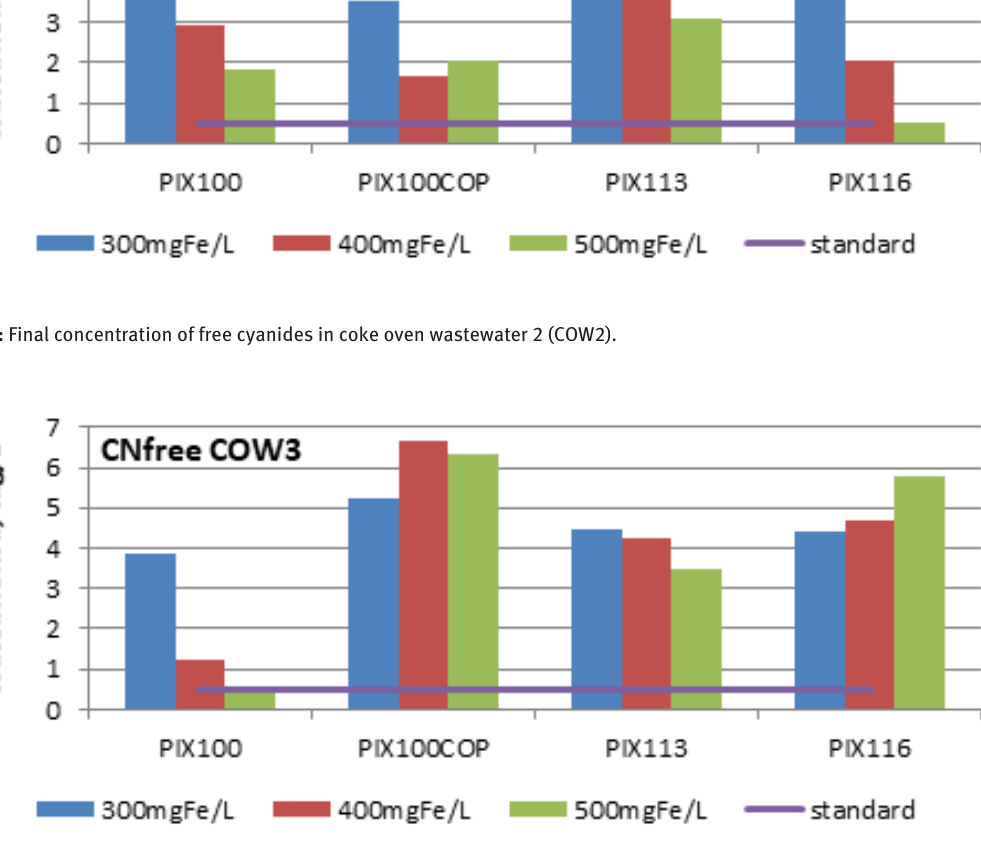
Figure 6: Final concentration of free cyanides in coke oven wastewater 3